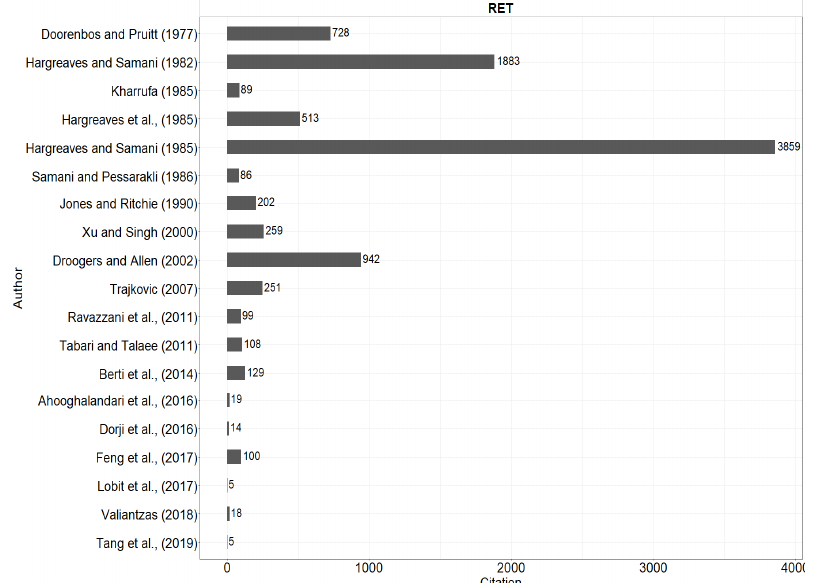
Figure 3. Citations of RET temperature-based equations.